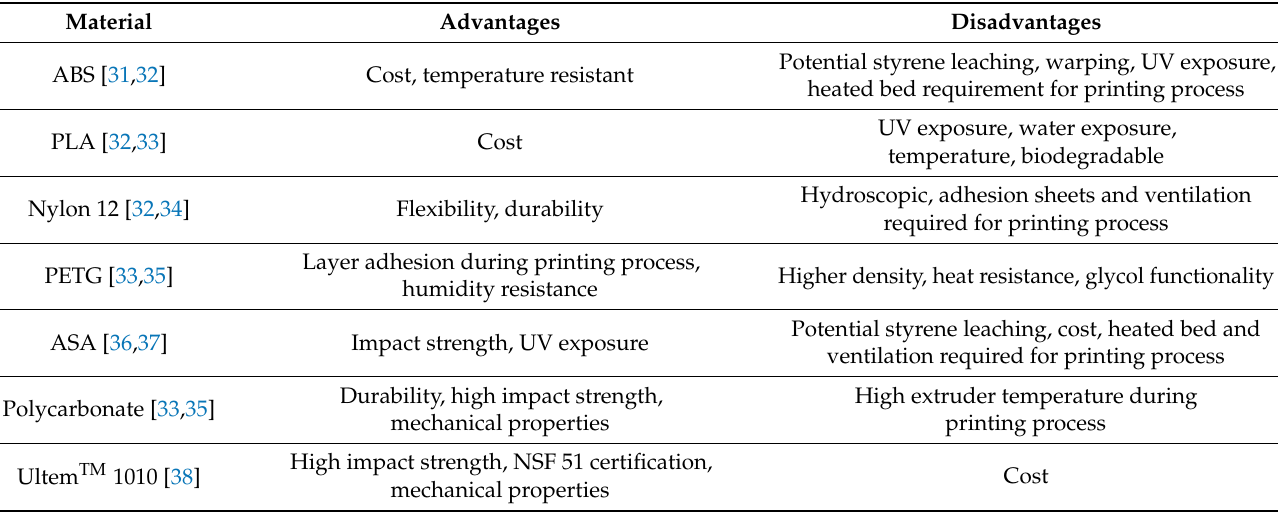
Table 2. Advantages and disadvantages of various 3D print